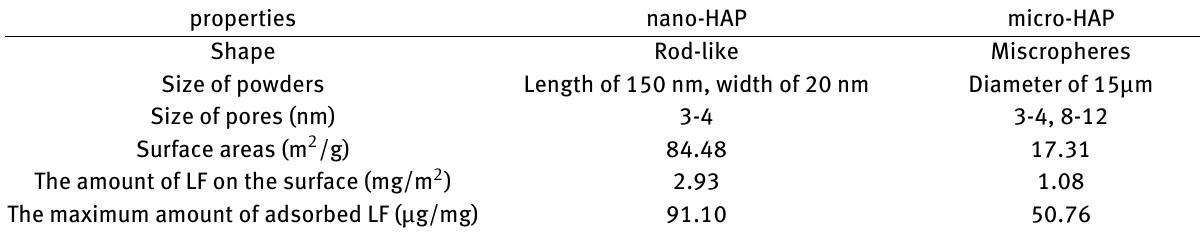
Table 1: Experimental profiles of two kinds of HAP properties